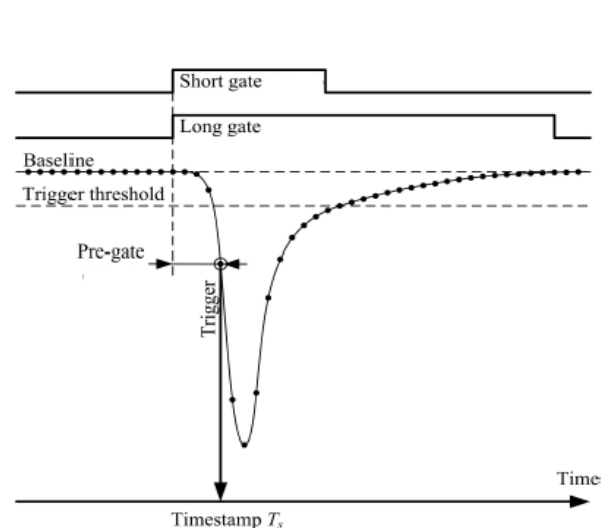
Figure 3 Most relevant parameters for the DPP firmware